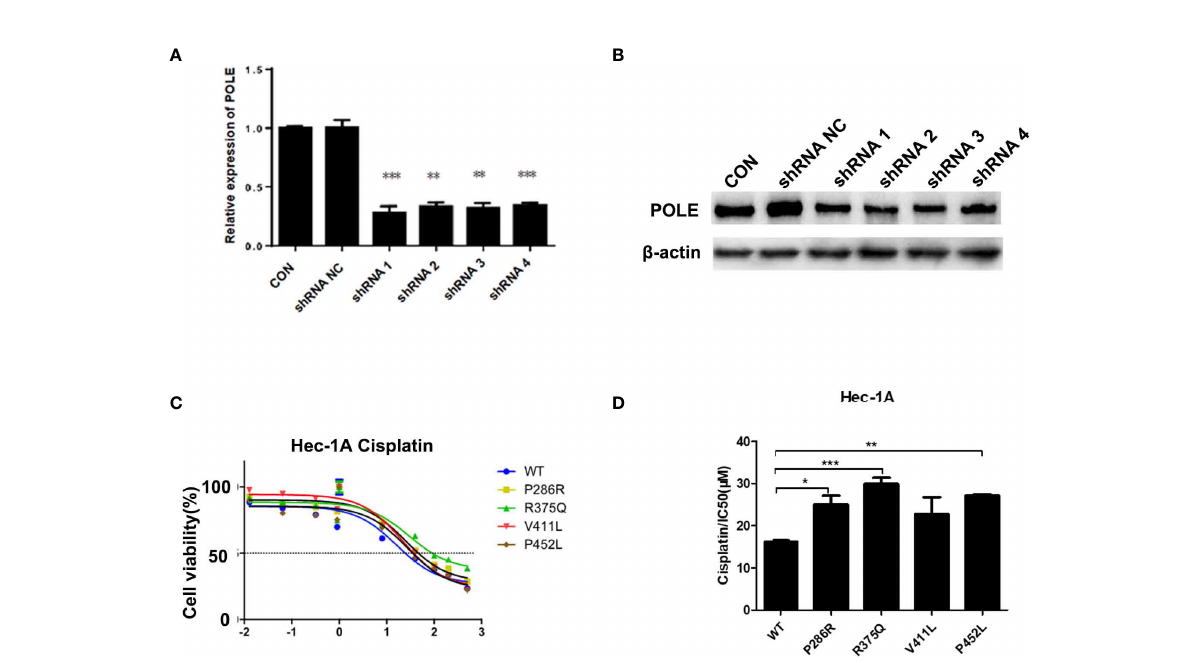
FIGURE 2 POLE EDMs induced cisplatin resistance in endometrial cancer cells. (A, B) HEK-293T cells were transfected with lentiviral vectors expressing negative control small hairpin RNA (shRNA NC) or shRNAs against POLE (shRNA1, shRNA2, shRNA3, or shRNA4). Quantitative real-time PCR (qRT-PCR) and Western blot analysis were performed at 48 h after transfection to determine mRNA and protein levels of POLE. (C, D) HEC-1A cells were transiently transfected with lentiviral vectors expressing wildtype POLE or P286R, R375Q, V411L, or P452L variant. Cells were treated with different concentrations of cisplatin (0.0001, 0.0128, 0.064, 0.32, 1.6, 8, 40, 100, 200, and 500 µmol/L) for 48 – 72 (h) MTT assay was conducted to measure the cell viability. IC50 was calculated. Data are expressed as the mean ± standard deviation (SD). * P < 0.05, ** P < 0.01, *** P < 0.001, vs. WT; n = 3. WT,